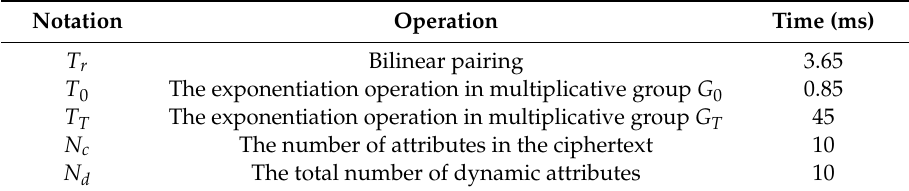
Table 4. Measurement of cryptographic operations (PBC-based